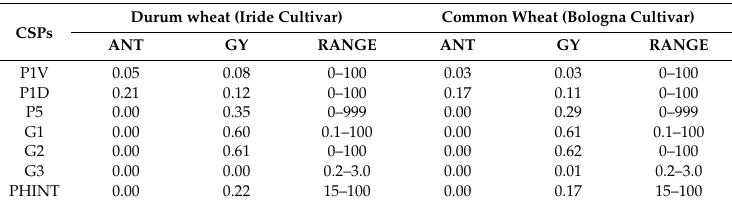
Table 5. Sensitivity index of the CSPs of CSM-CERES-Wheat crop model for anthesis date (ANT) and grain yield (GY) of Iride and Bologna cultivars and range are considered.